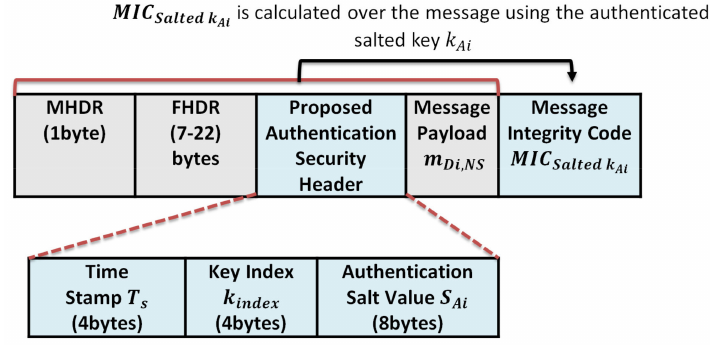
Figure 14. The proposed protocol authenicated message format.